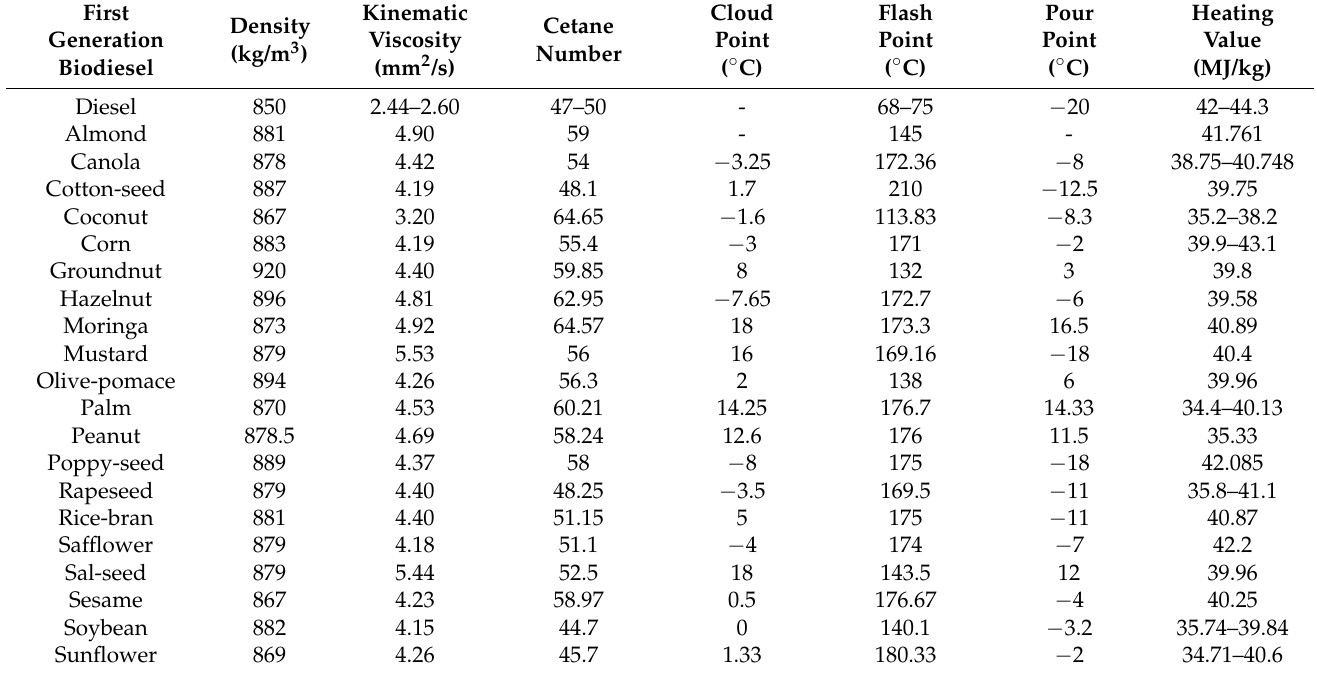
Table 4. Properties of first-generation biodiesel